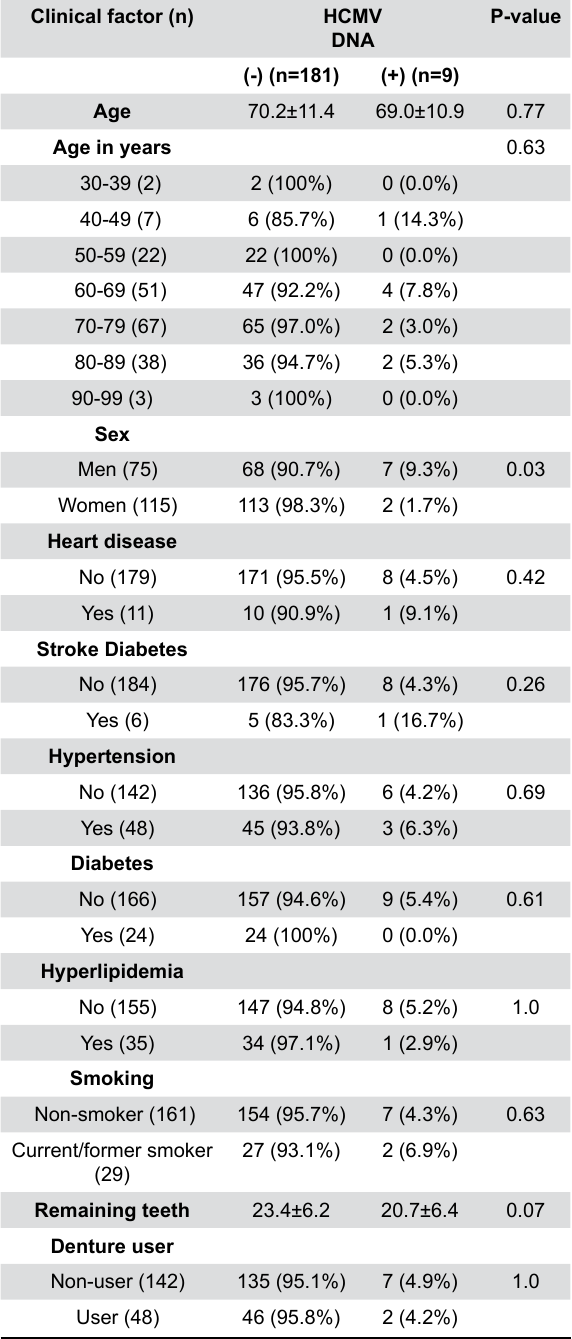
Table 1- Associations of oral HCMV DNA with clinical